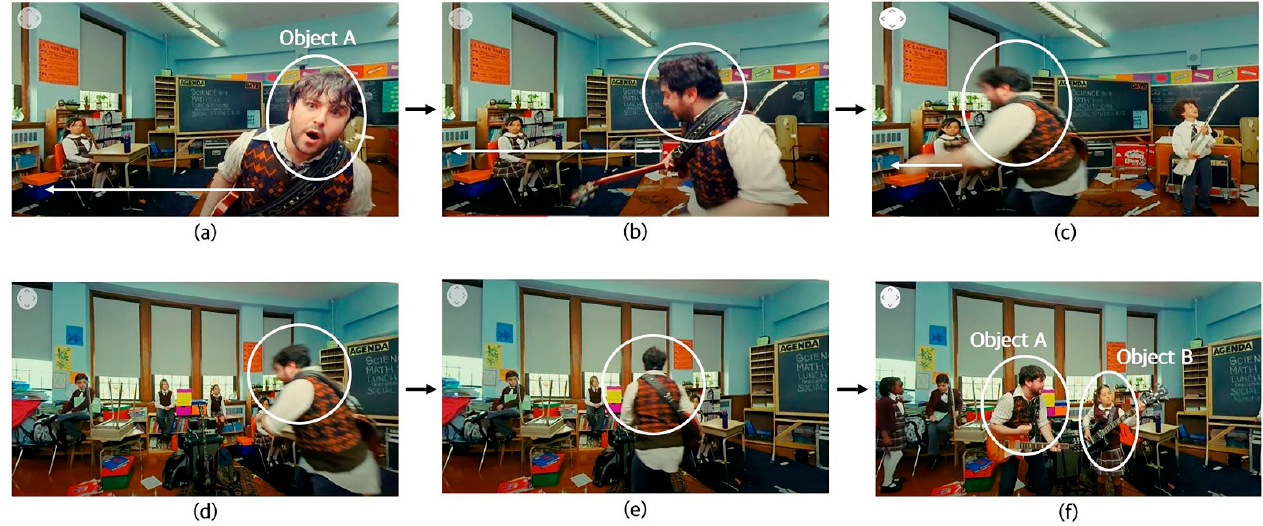
Figure 1. Directed Case 1 using “Object Movement” (video No. 5). ( a ) The user’s attention is fixed to object A, ( b , c ) Object A starts to move in the left direction, ( d , e ) The user’s attention moves to the left along object A, ( f ) Objects A and B play instruments together in the position intended by the director.